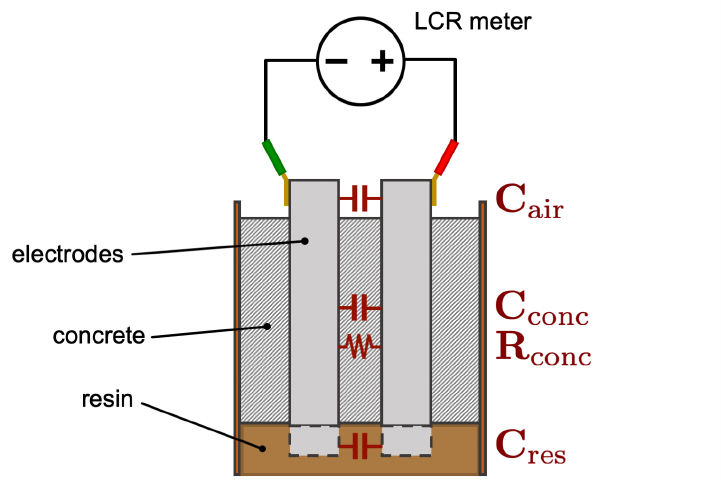
Figure 6. Schematization of the cross section of the device for the measurement of electric resistivity and permittivity. The lumped capacitances and resistances between the electrodes associated with the different materials are indicated in red.